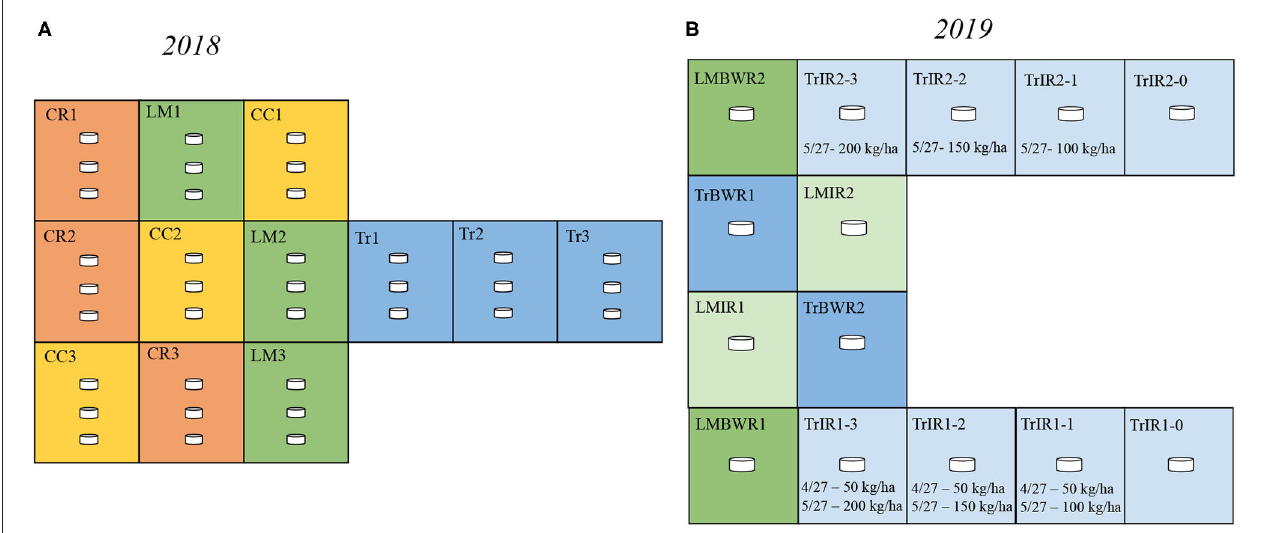
FIGURE 1 | Experimental design in 2018 and 2019. (A) In 2018, our design consisted of three replicate plots of each agricultural practices [crimson clover (CC), yellow; cereal rye (CR), red; living mulch (LM), green; conventional (Tr), blue]. In each plot, there were three chambers. (B) In 2019, our design consisted of 14 plots: two plots for Traditional between-row (TrBWR), Living mulch in-row (LMIR), and Living mulch between-row (LMBWR), (TrBWR, blue; LMIR, light green; LMBWR, green), as well as eight plots for Traditional in-row (TrIR) with varying N fertilizer inputs marked by light blue. Details regarding the N fertilizer amount and dates are